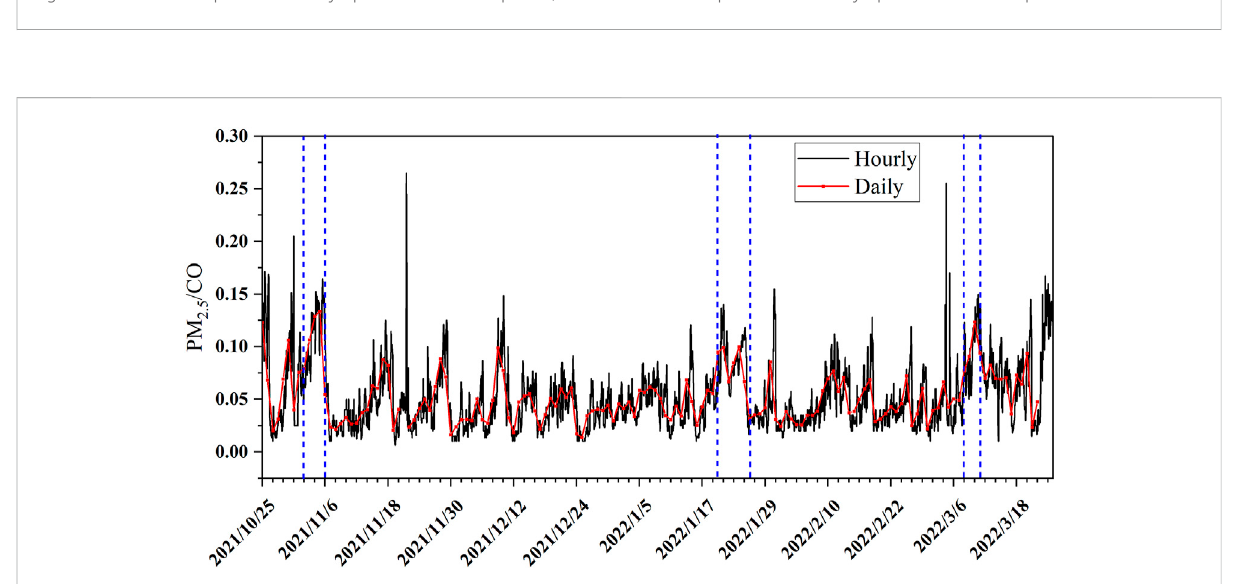
FIGURE 7 Time series of hourly and daily PM 2.5 /CO mass ratios; the three polluted episodes are marked by blue dashed